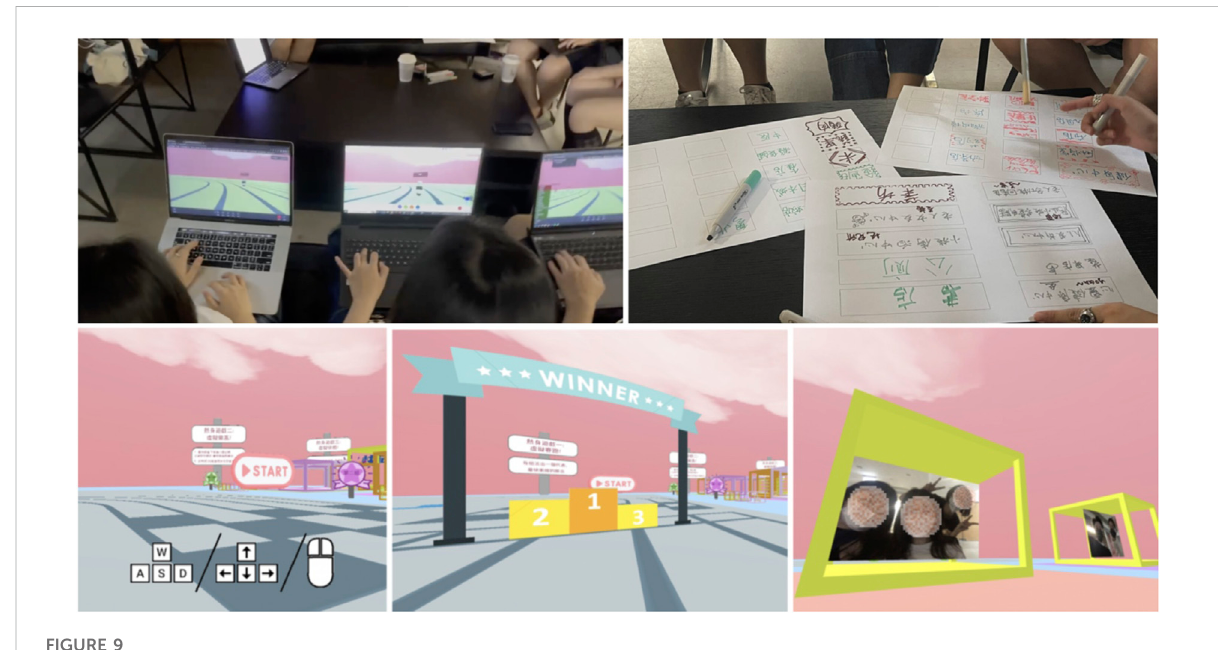
FIGURE 9 Phase 2 playday and screenshots of Chapter 1 — warm-up minigames in